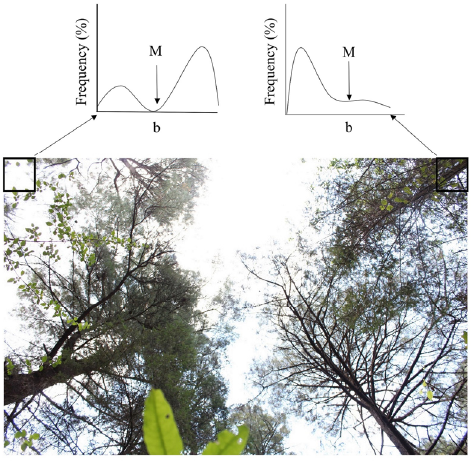
Figure 4. Outline of thresholds in blocks by the adaptive threshold method; the left part of the histogram corresponds to pixels with vegetation, the right side of the histogram corresponds to pixels without vegetation. The M value is the threshold for each block.